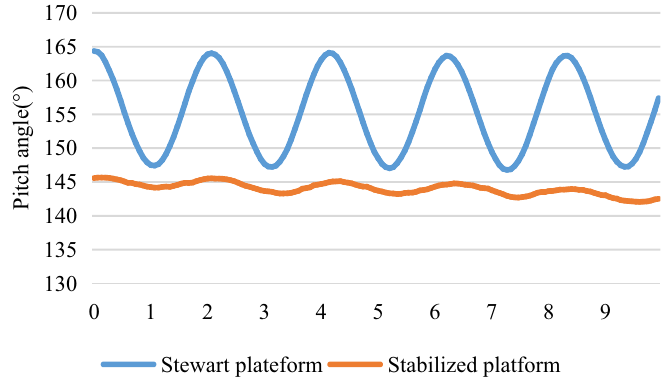
Figure 9. Motion compensation effect of mechanical